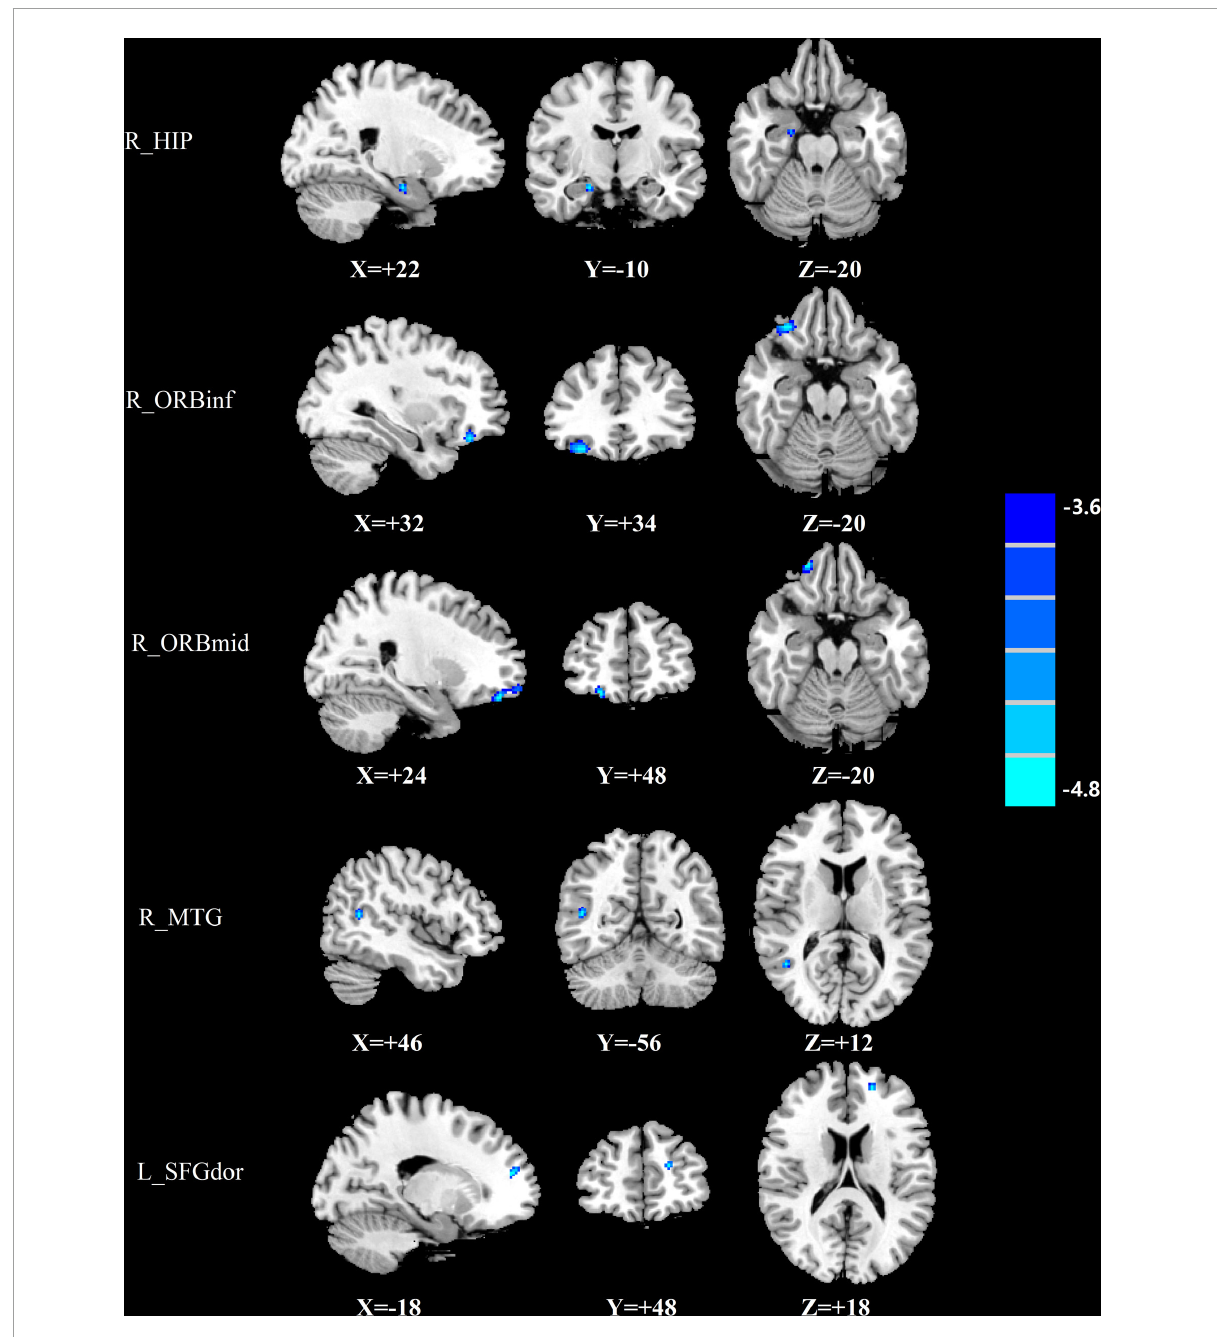
FIGURE1 Brain regions showing significant differences in normalized CBF between men patients and men controls. The cold color indicates that the normalized CBF was significantly decreased in the men patients. CBF, cerebral blood flow; R, right; L, left; HIP, Hippocampus; ORBinf, inferior frontal gyrus, orbital part; ORBmid, middle frontal gyrus, orbital part; MTG, middle temporal gyrus; SFGdor, superior frontal gyrus, dorsolateral.